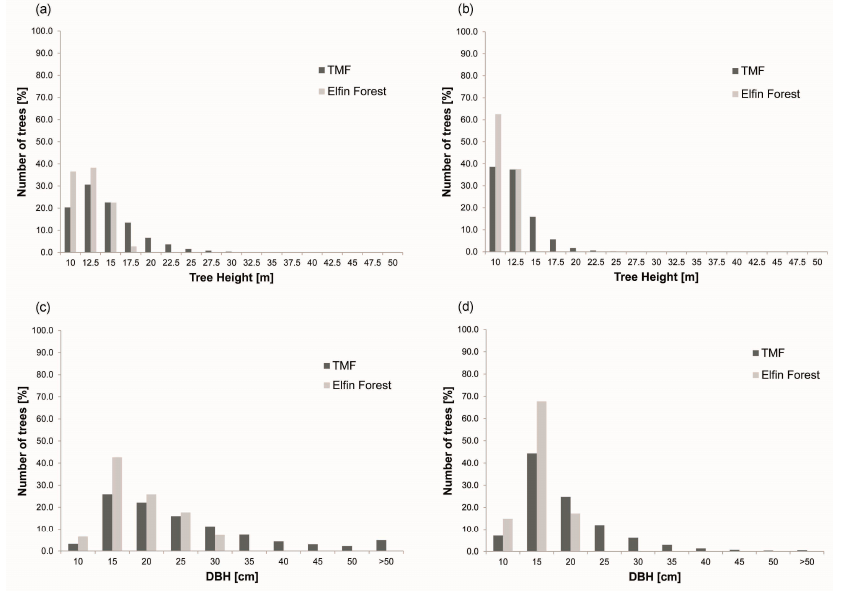
Figure 9. Portion of trees in the established H (above) and DBH (below) classes, divided in ravine forest: ( a , c ), and ridge forest ( b , d ).